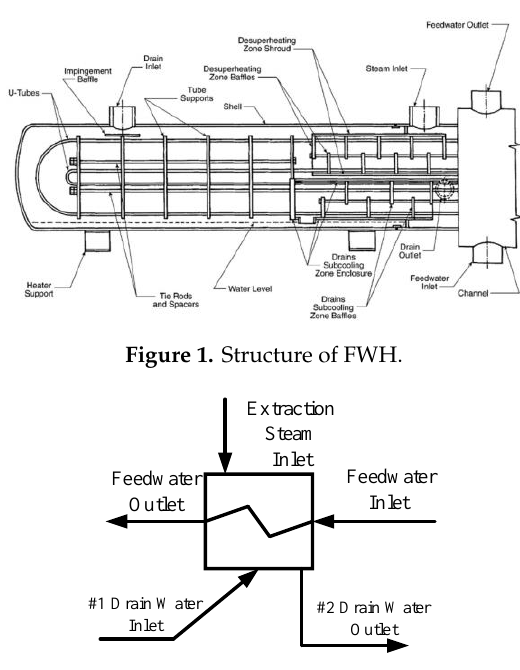
Figure 2. Thermodynamic diagram of #2 FWH.